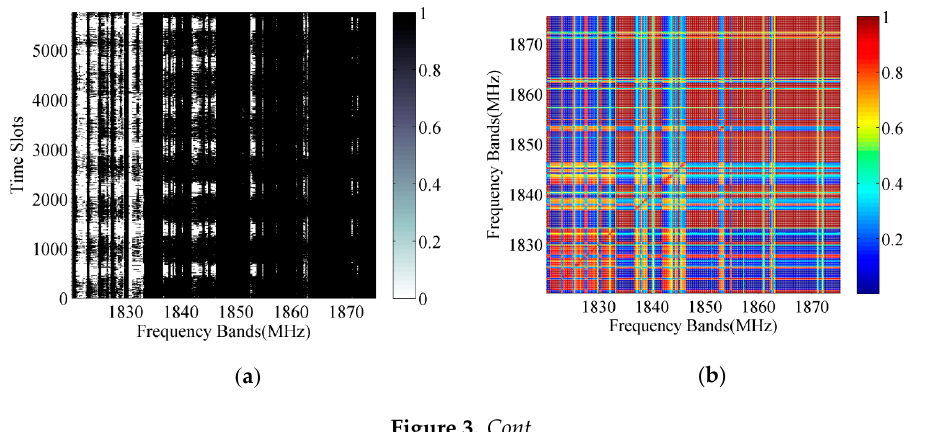
Figure 3. Channel occupancy and channel correlation distribution. ( a ) NE GSM1800 DL channel occupancy distribution. ( b ) NE GSM1800 DL channel correlation distribution. ( c ) NE TV channel occupancy distribution. ( d ) NE TV channel correlation distribution. As shown in Figure 3, I would rather say that a block-correlation pattern is evident, which confirms the motivation for considering contiguous aggregation (clustering) of frequency bins. 3.3. OPTICS Algorithm for Channel Clustering As anticipated in Section 1, GC, MEI and MCC have their limitations for channels clustering. While sub-channels of wideband spectrum are regarded as the objects of the spectrum space, the density-based OPTICS [27] clustering algorithm is applied for channels clustering in this paper, which is an extension of the Density-Based Spatial Clustering of Applications with Noise (DBSCAN) [28]. DBSCAN is a density-based clustering algorithm to look for high-density areas separated by low-density areas, and all the points are marked as core point, border point or noise point respectively depending on the density of the area where this point is located. In this algorithm, an edge is assigned between all the core points within the distance predefined, and each group of connected core points forms a cluster, then each border point is assigned to a cluster of associated core points. The advantage of DBSCAN algorithm is relatively noise-resistant and can deal with clusters of any shape and size, and one of the disadvantage is high dependence on input parameters, which is improved in OPTICS algorithm. The OPTICS algorithm starts from a randomly selected core object and preferentially expands toward high-density data areas. At the same time, the neighborhood objects are output in an ordered list according to the density, and clusters of different densities are displayed according to the reachability-distance curve of the channel. However, the data clustering is not explicitly generated, and the final clustering result can be obtained from the ordered list or the reachability-distance curve ( c )